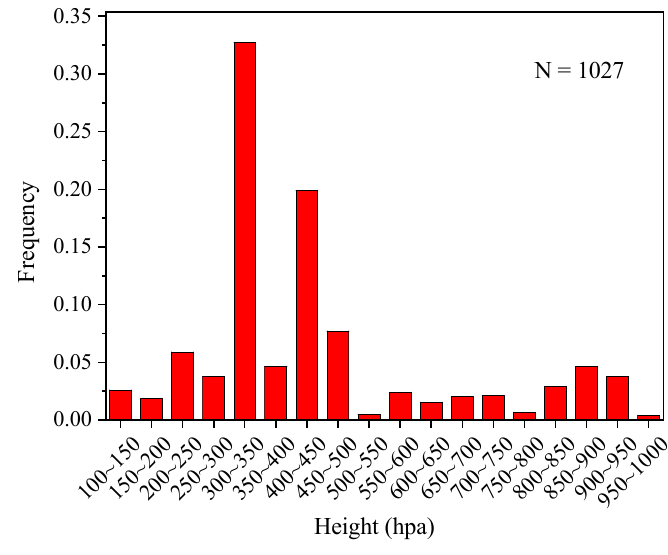
Figure 3. Warm core height distribution.